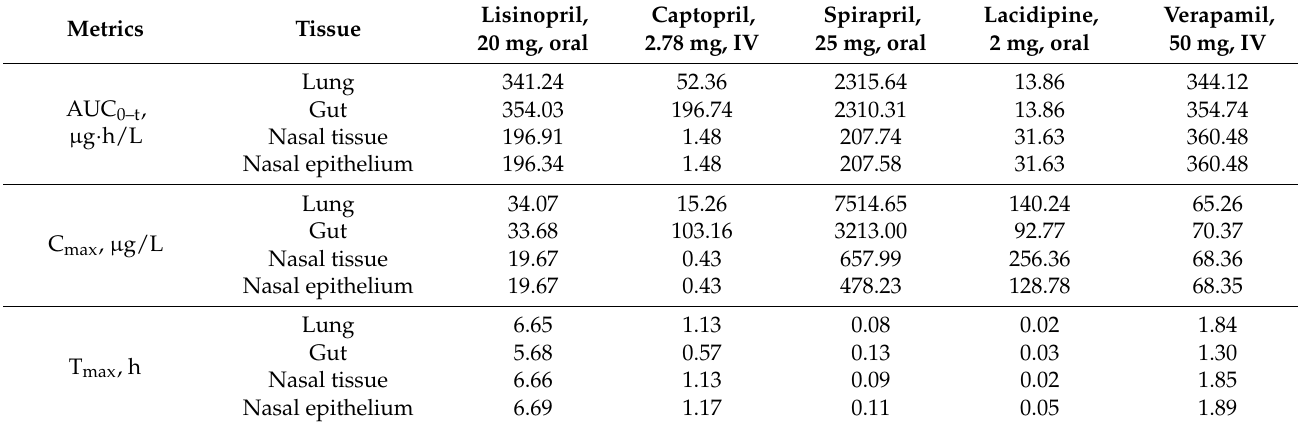
Table 5. PK metrics calculated from simulations of drug distribution to ACE-expressing organs and tissues.